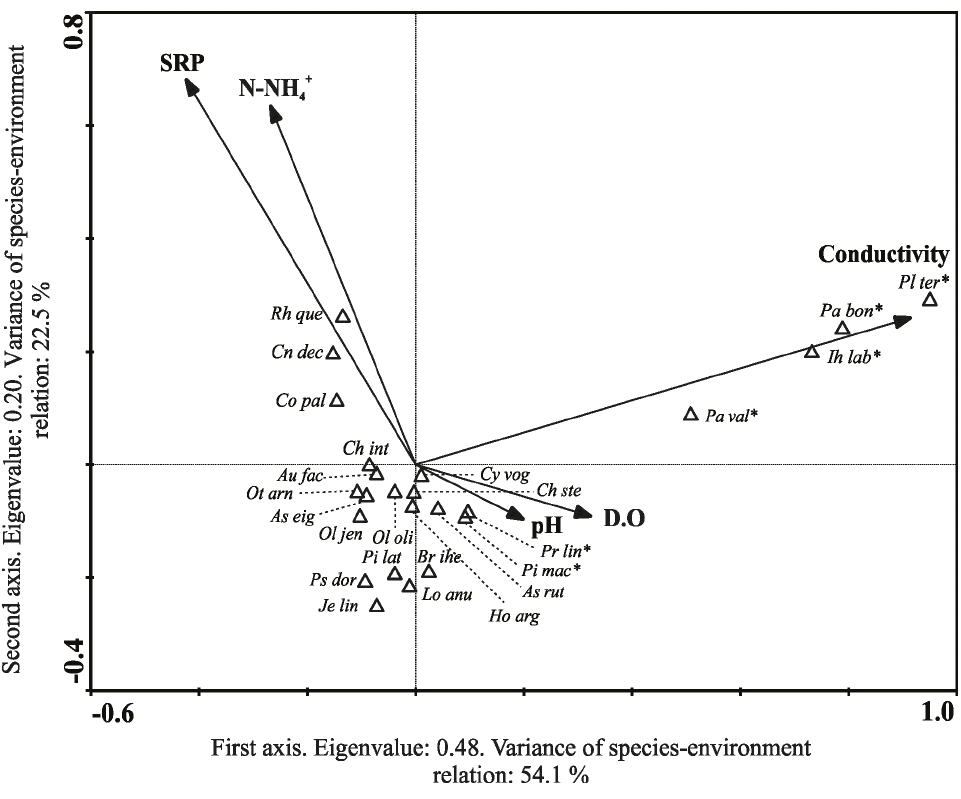
Figure 6. Canonical correspondence analysis. Biplot of species and environmental variables in measured in pampean streams, Buenos Aires province, Argentina. Species with an asterisk are riverine. Cn dec, Cnesterodon decemmaculatus; Rh que, Rhamdia quelen; Co pal, Corydoras paleatus; Ch int, Cheirodon interruptus; Ot arn, Otocinclus arnoldi; As eig, Astyanax eigenmanniorum; Ch ste, Charax stenopterus; As rut, Astyanax rutilus; Cy vog, Cyphocharax voga; Pr lin, Prochilodus lineatus; Pi mac, Pimelodus maculatus; Ol oli, Oligosarcus oligolepis; Ol jen, Oligosarcus jenynsii; Au fac, Australoheros facetus; Ho arg, Hoplias argentinenensis, Ps dor, Pseudocorynopoma doriae; Pi lat, Pimelodella laticeps; Je lin, Jenynsia lineata; Lo anu, Loricariichthys anus; Br ihe, Bryconamericus iheringii; Pa val, Parapimelodus valenciennis; Ih lab, Iheringichthys labrosus; Pa bon, Pachyurus bonariensis; Pl ter, Plagioscion